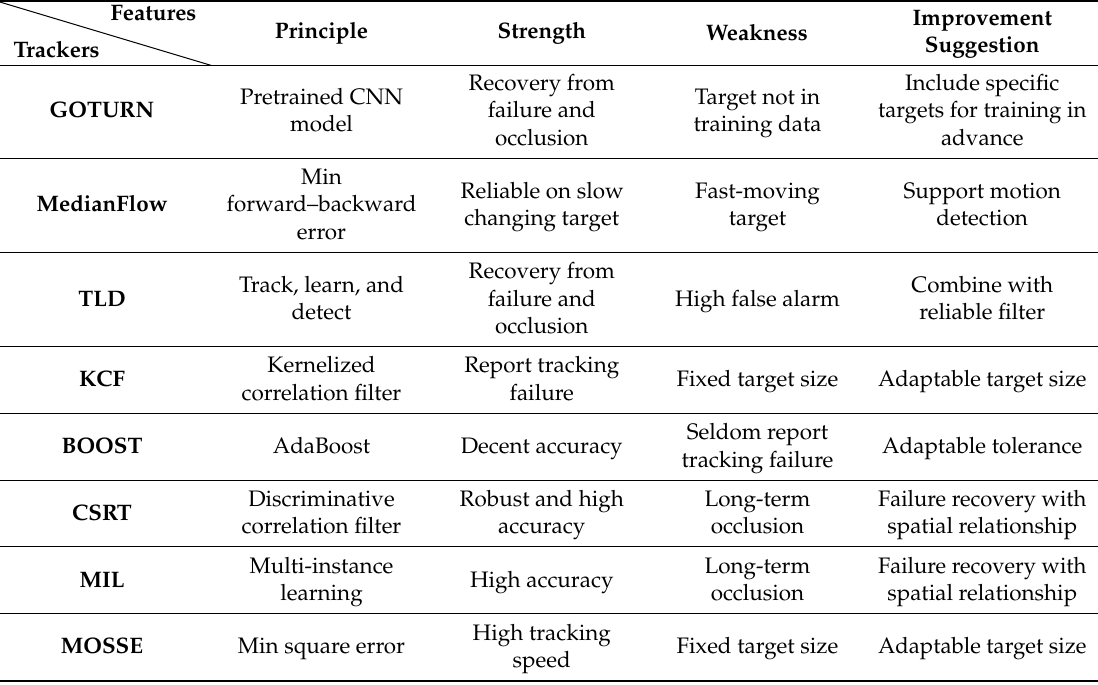
Table 4. Strengths and weaknesses of all eight trackers on 360-degree